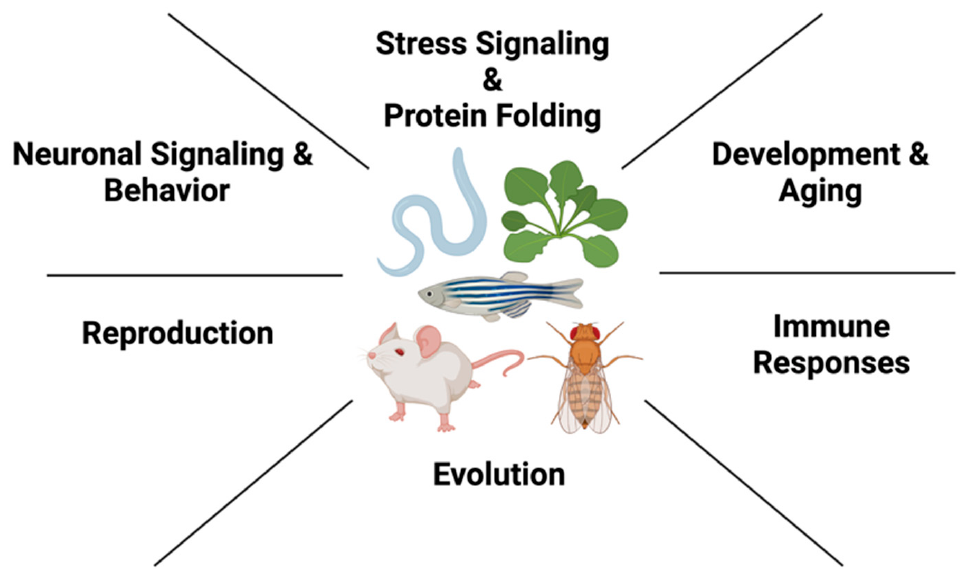
Figure 1. Organismal roles of Hsp90 in different multicellular model systems. In metazoans, such as C. elegans , Mus musculus , D. melanogaster , Danio rerio and A. thaliana , Hsp90 acts in diverse biological processes to ensure organismal proteostasis.